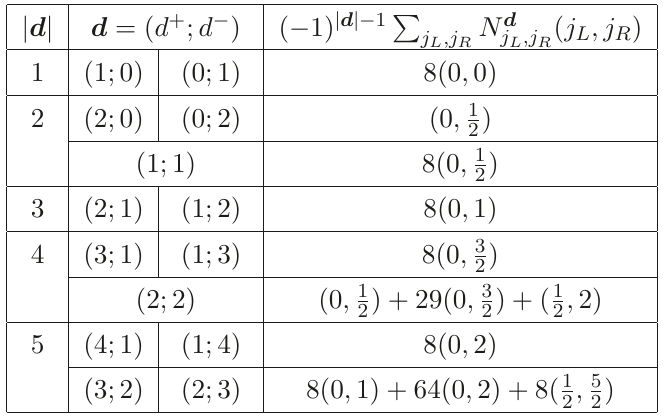
Table 1 . The BPS indices N d identified for the (2 , 2) model under the assumption of two K¨ahler j L ,j R parameters with the opposite B -field effect